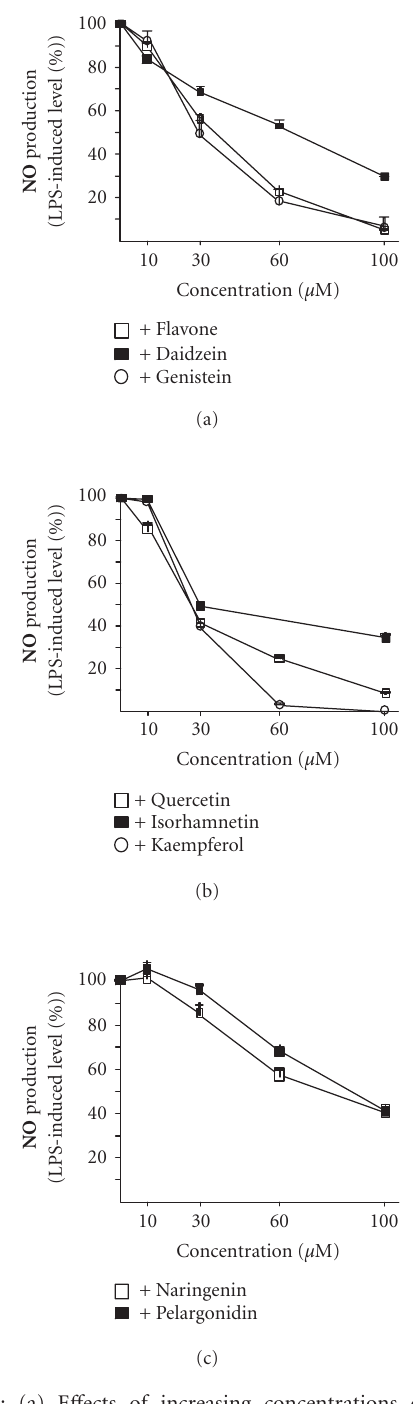
Figure 2: (a) E ff ects of increasing concentrations of flavone, daidzein, and genistein on LPS (100ng/ml)-induced NO produc- tion in J774 cells during a 24-hour incubation time. (b) E ff ects of in- creasing concentrations of quercetin, isorhamnetin, and kaempferol on LPS (100 ng/ml)-induced NO production in J774 cells during a 24-hour incubation time. (c) E ff ects of increasing concentrations of naringenin and pelargonidin on LPS (100ng/ml)-induced NO pro- duction in J774 cells during a 24-hour incubation time. NO pro- duction was determined by measuring nitrite accumulation in the culture medium by Griess reaction. Mean + SEM, n =